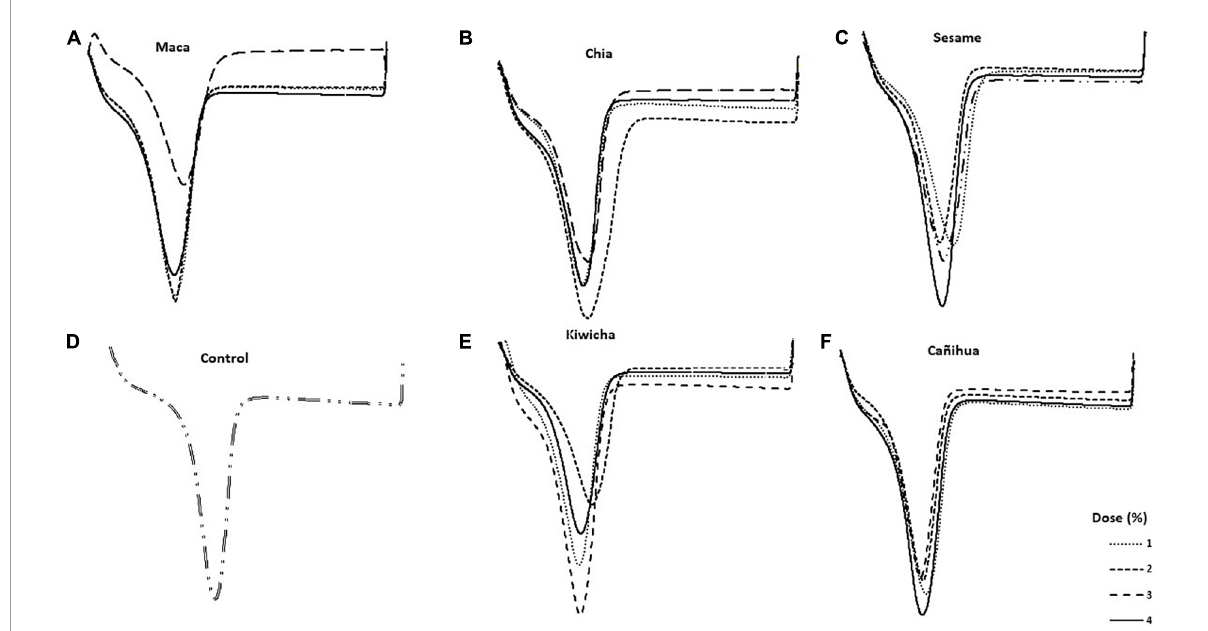
FIGURE4 Typical differential scanning calorimetry curves of dark chocolates with the addition of flours. (A) Maca, (B) ajonjolí, (C) kiwicha, (D) cañihua, (E) chia, and (F) with no